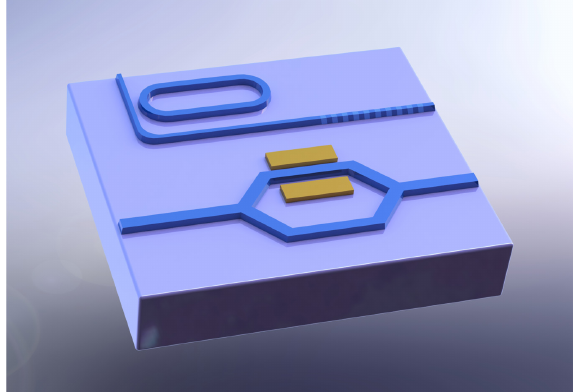
Figure 1: Schematic view of an integrated LNOI photonics chip. Waveguides, resonators, periodically poled lithium niobate, modulators, and many other structures and devices can be integrated onto a single LNOI chip to achieve various systems and